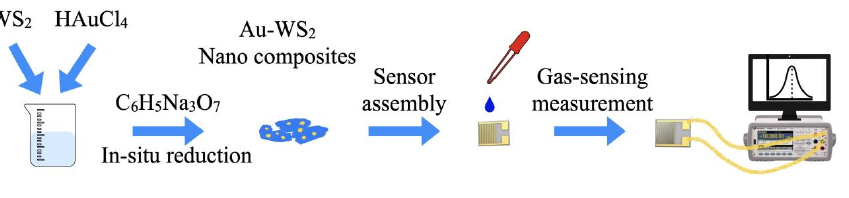
Figure 1. Schematic diagram of synthesis and gas sensing measure of Au/WS 2